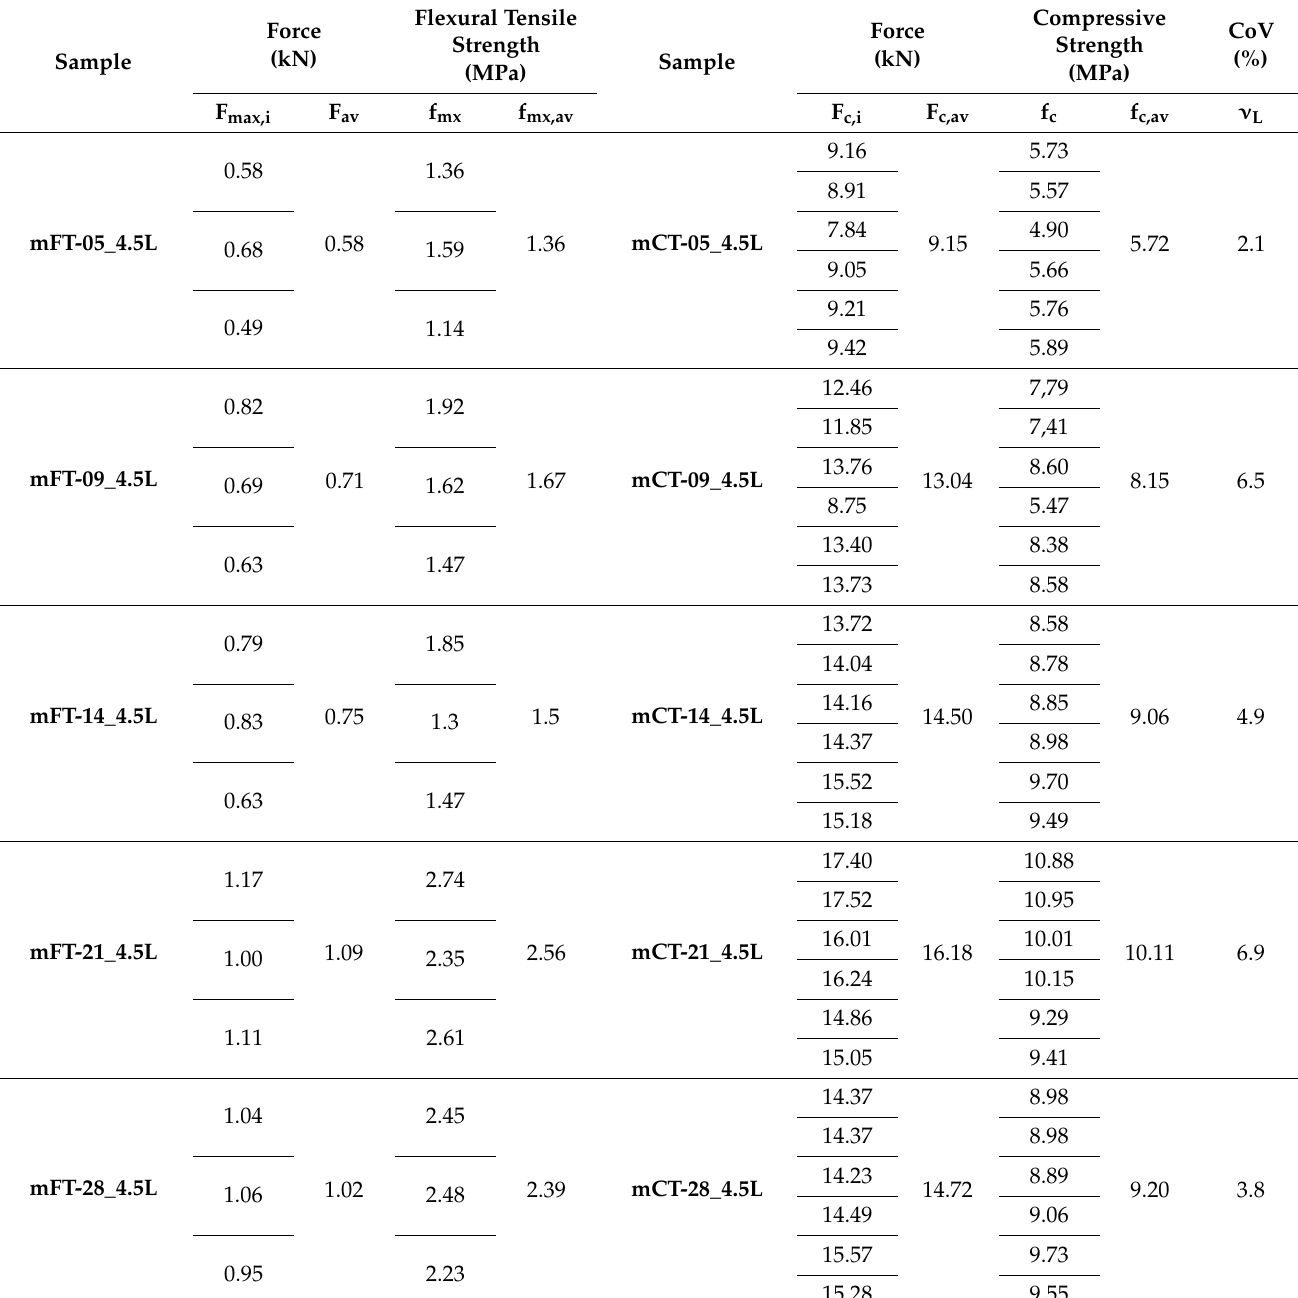
Table 3. Flexural and compressive strengths—mortar made with 4.5 L of mixing water per 25 kg